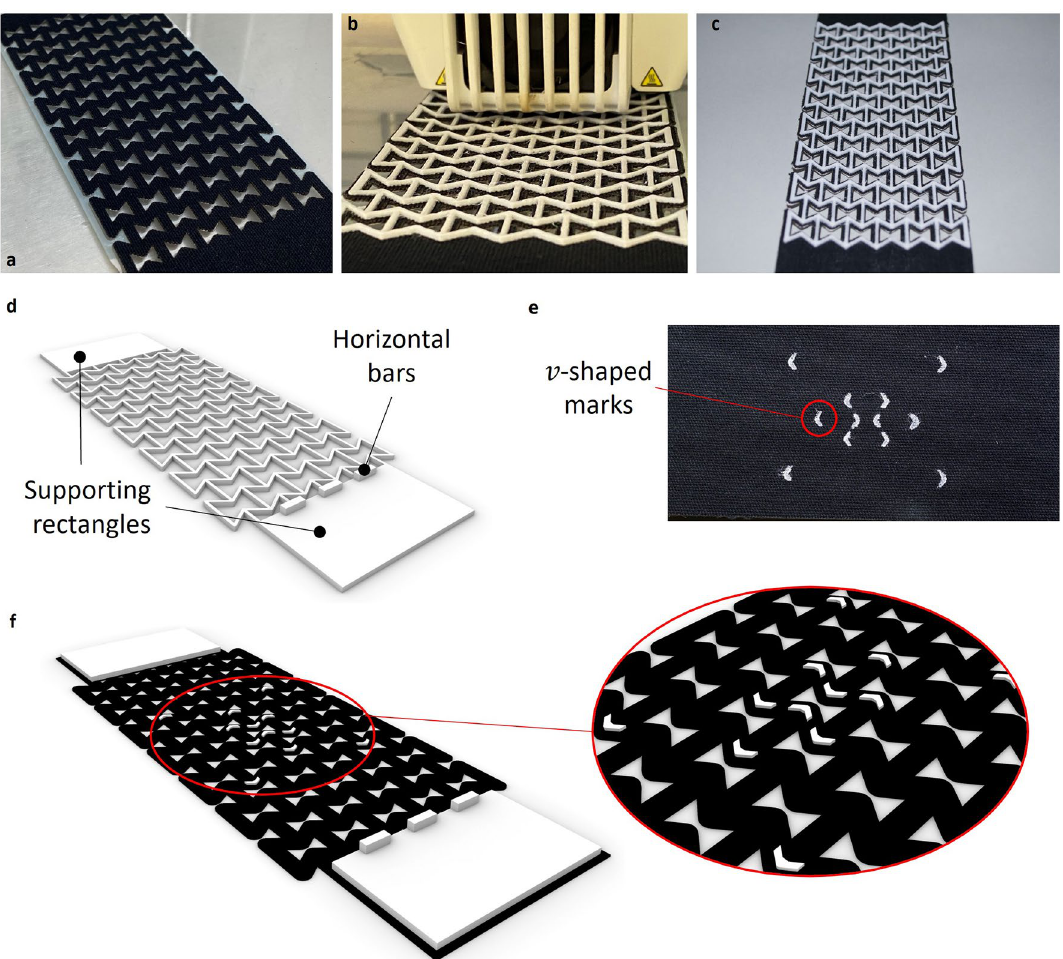
horizontal bars are added to the auxetic structures used for the mechanical characterization. ( e ) v -shaped marks indicated on the only tape samples (Structure 1 in Fig. 5c) as relevant points for measuring the Poisson’s ratio. (f) The sample used for Structure 2 (Fig. 5c) and a detail of the v -shaped